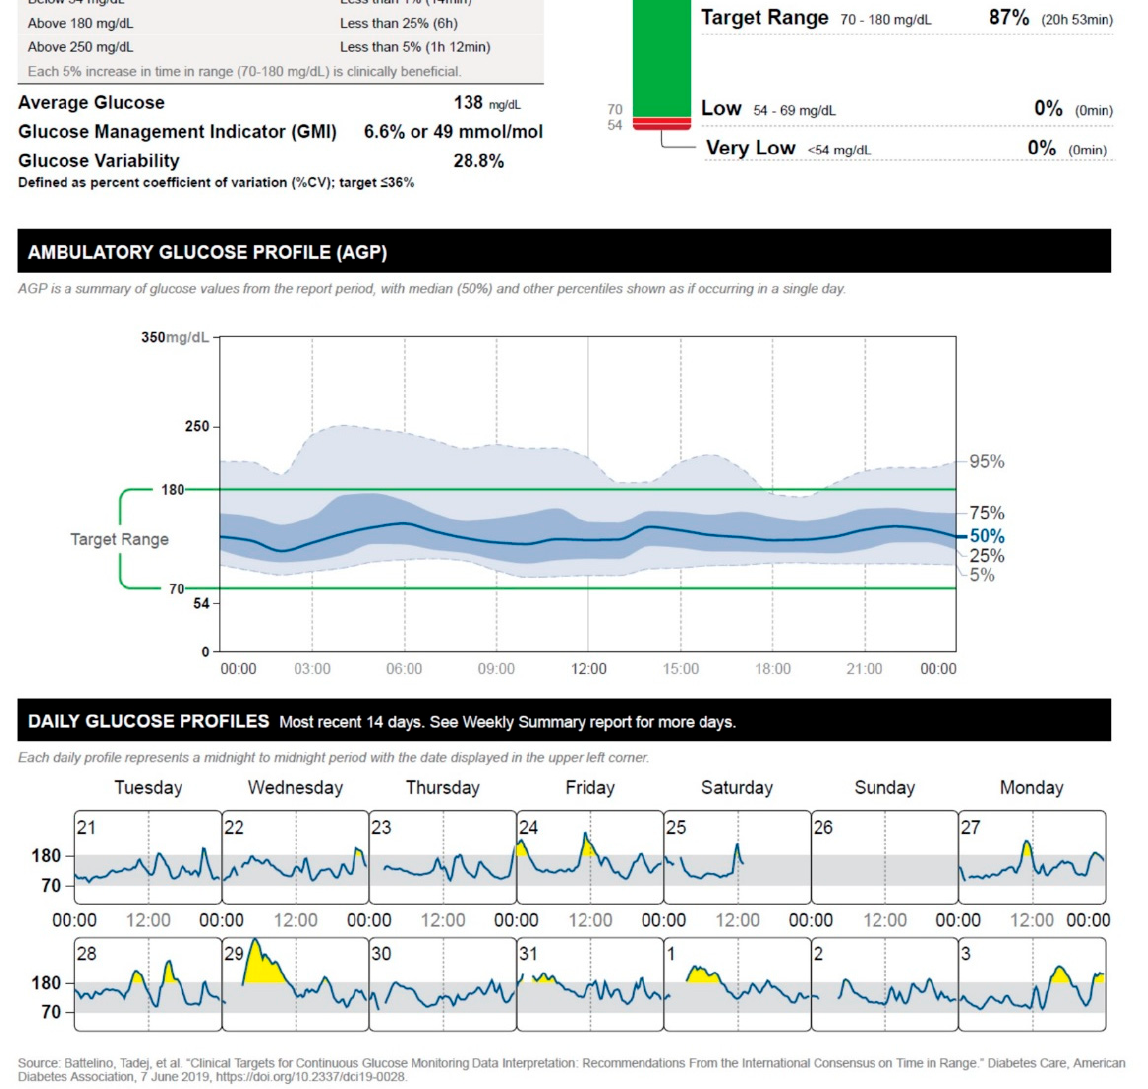
Figure 2. Ambulatory glucose profile (AGP) obtained from the subcutaneous glucose sensor referring to the 21 days after the first vaccine dose injection (14 December 2021 through 3 January 2022).